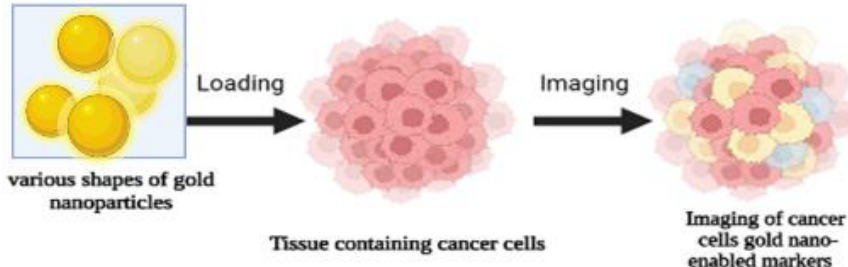
Figure 4. Applications of gold nanoparticles in cancer imaging and detection. Table 3. Application of gold nanoparticles in cancer imaging and diagnosis.